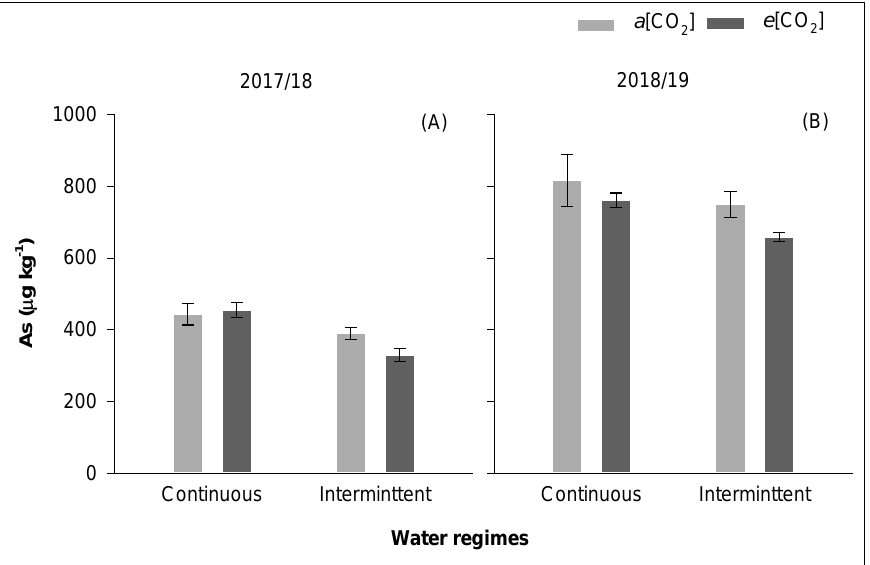
Figure 7. Effect of CO 2 concentrations ( a [CO 2 ] = 400 μmol mol −1 and e [CO 2 ] = 700 μmol mol −1 ) and water regime (continuous vs. intermittent flood) on total arsenic (µg kg −1 ) in husked rice grain plants in 2017/18 ( A ) and 2018/19 ( B ) growing season. Error bars correspond to 95% confidence intervals.